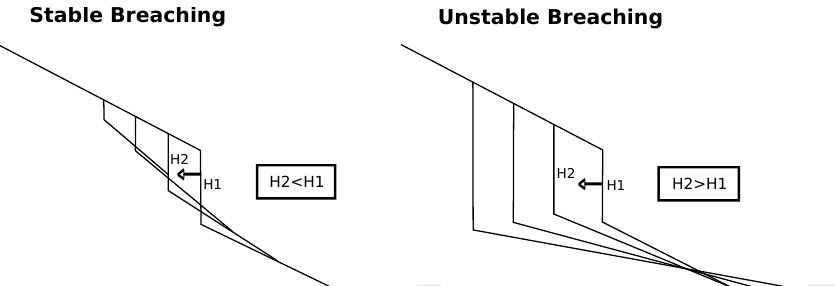
Figure 3. Schematic illustration of the two types of breaching, stable breaching ( left ) and unstable breaching ( right ); H is the breach height and the horizontal axis represents time, with the permission from Van Rhee, C. 2015 (adapted from